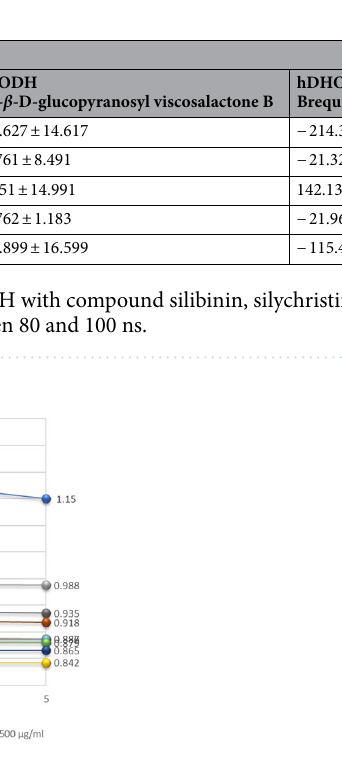
Figure 9. Time-absorption curve for Curcuma longa (CL) 500 ug/ml , silymarin standard (SM) 500 ug/ml , Salvia officinalis (SO) 500 ug/ml, Allium sativum (AS) 500 ug/ml , Glycyrrhiza glabra (GG) 500 ug/ml , Olea europaea (OE) 500 ug/ml , Zingiber officinale (ZO) 500 ug/ml and silibinin 400